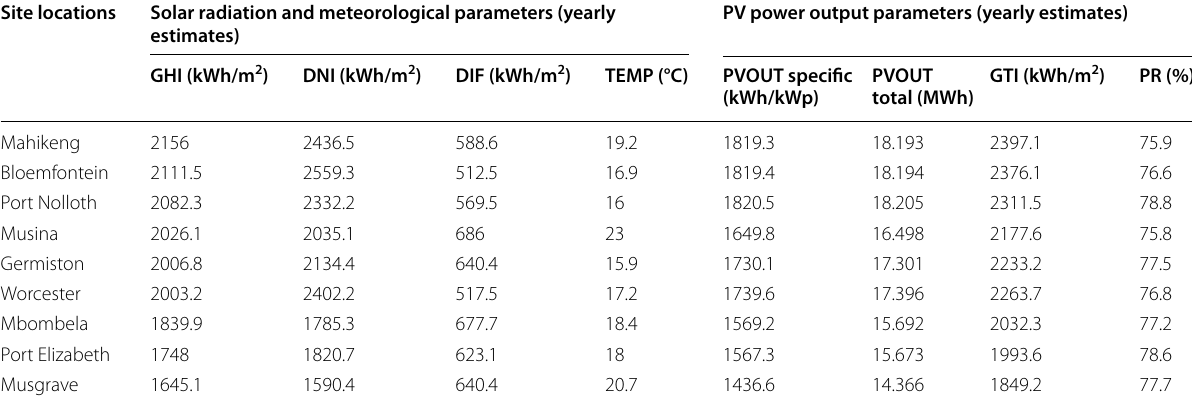
Table 5 Radiation and meteorological parameters Site